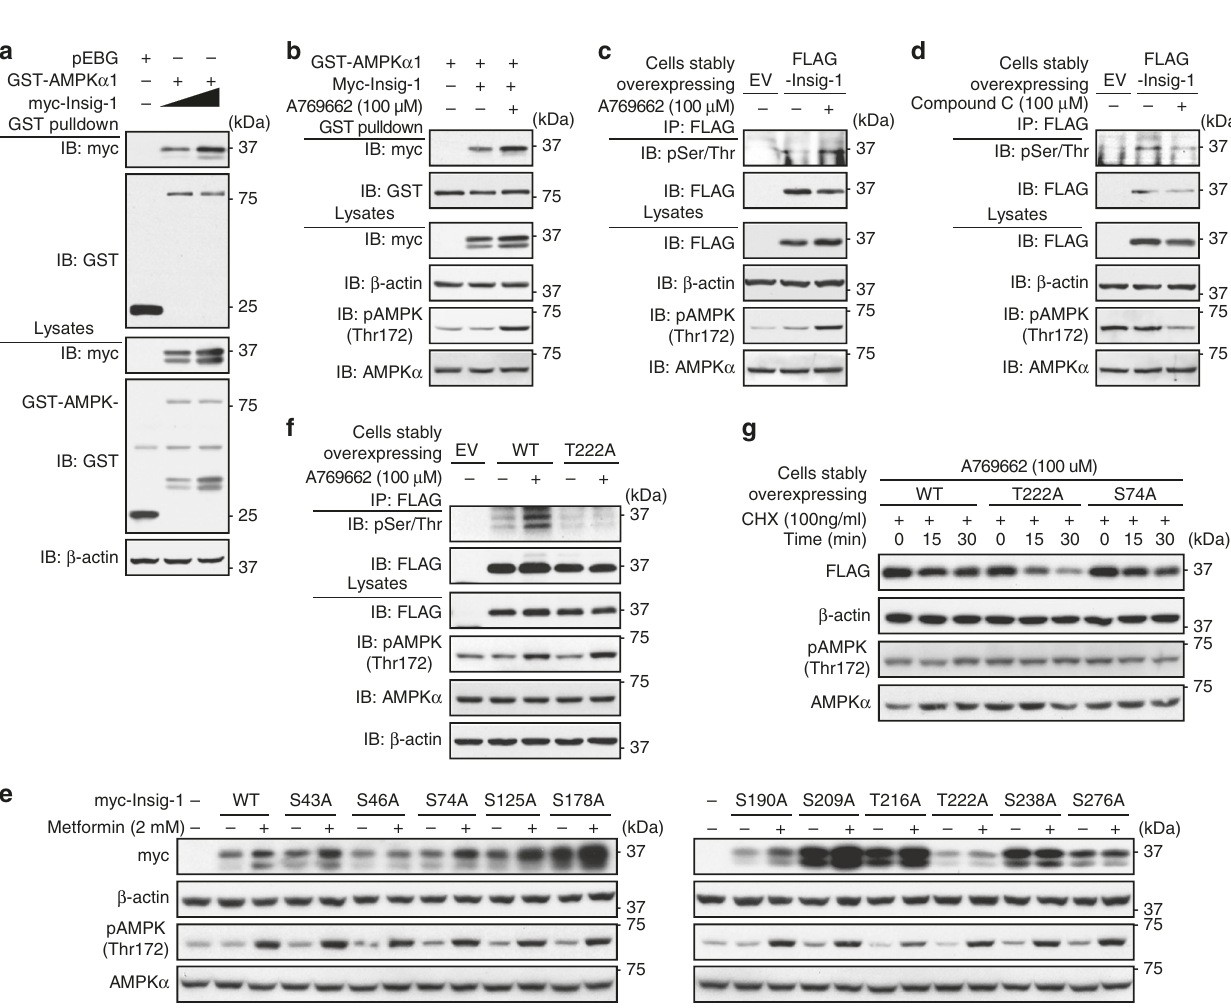
Fig. 5 Insig-1 is a downstream target of AMPK. a AMPK α 1 subunit associates with Insig-1 in a dose-dependent manner. HEK293 cells were transfected with myc-Insig-1, GST-AMPK α 1, and pEBG (empty vector) as indicated for 48 h, and puri fi ed with GSH Sepharose beads. b AMPK activation by A769662 enhances the association between AMPK α 1 and Insig-1. HEK293 cells were transfected with myc-Insig-1 and GST-AMPK α 1 as indicated for 24 h, followed by treatment with 100 μ M A769662 for 8 h, and then puri fi ed with GSH Sepharose beads. The precipitates and lysates were immunoblotted with antibodies against myc or GST. c , d Insig-1 is phosphorylated by AMPK. Insig-1 is phosphorylated in response to A769662 ( c ), whereas the phosphorylation level is inhibited by compound C ( d ). HEK293 cells stably expressing FLAG-tagged Insig-1 or empty vector (EV) were treated with 100 μ M A769662 or 20 μ M compound C for 30 min. The cell lysates were incubated with FLAG antibodies and puri fi ed with protein A/G-Sepharose beads. The precipitates were immunoblotted with antibodies against phosphoserine/threonine (anti-pSer/Thr). e The effects of metformin on various Insig-1 mutants. HEK293 cells were transfected with pcDNA or myc-tagged Insig-1 nonphosphorylatable mutant plasmids for 24 h, followed by treatment with 2 mM metformin for 24 h. Immunoblots were performed. f AMPK phosphorylates human Insig-1 at Thr222. HEK293 cells stably expressing FLAG-tagged Insig-1 or T222A mutant were treated with 100 μ M A769662 for 30 min. The cell lysates were incubated with FLAG antibodies and puri fi ed with protein A/G- Sepharose beads. The precipitates were immunoblotted with antibodies against anti-pSer/Thr. g T222A mutant, but not WT or S74A mutant of Insig-1, is unstable and resistant to AMPK activation. HEK293 cells stably expressing FLAG-tagged WT, T222A, or S74A mutant of Insig-1 were treated with 100 μ M A769662, followed by incubation in the medium containing 100 ng/ml cycloheximide for the indicated